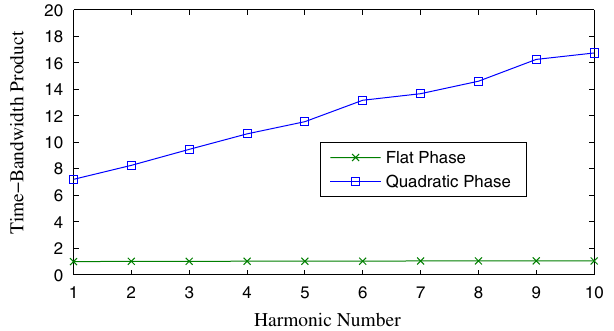
FIG. 3. The rms TBP, c (cid:1) T (cid:1) k , for the electron bunching FEL FEL factor of Fig. 2. The TBP increases at higher harmonics (blue squares), but slower than would be expected from a flattop pulse. For comparison, a transform-limited pulse with flat phase has minimal TBP at all harmonics (green crosses).